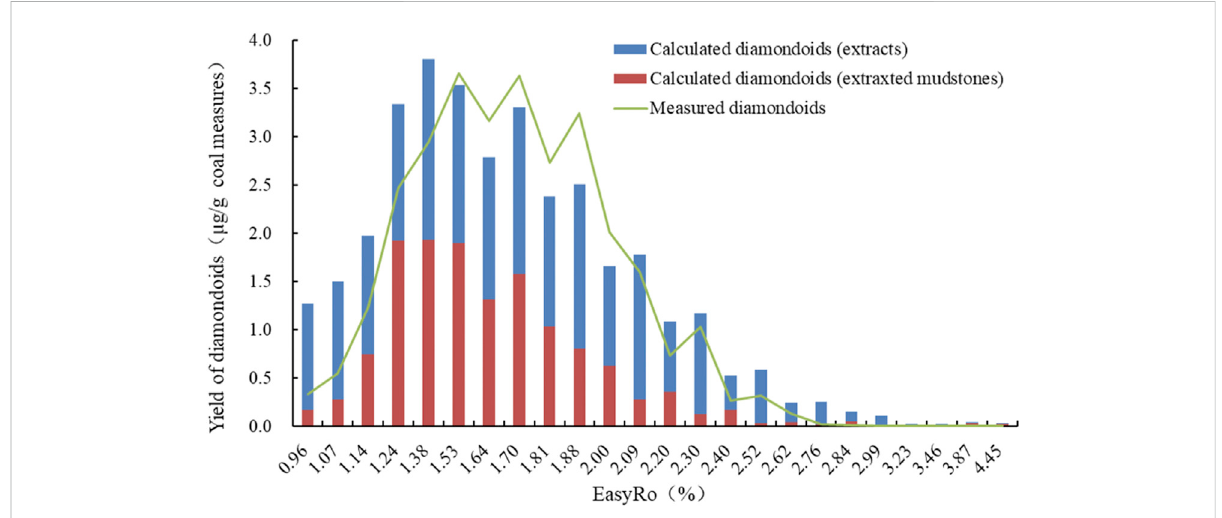
Variation in the yields ( μ g/g) of calculated diamondoids (extracts), calculated diamondoids (extracted mudstones), and measured diamondoids (Fang et al., 2015a) with EasyRo